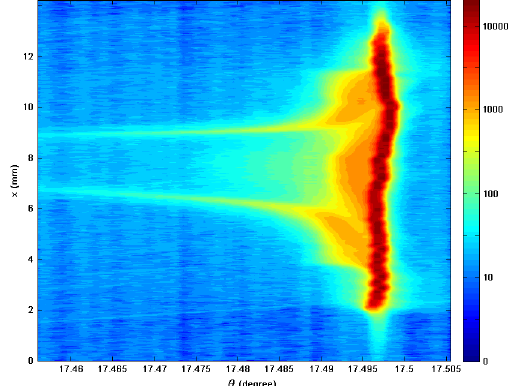
FIG. 11. Counts on the CCD detector as a function of the position along a diameter of the circular damage region ( x , vertical axis) and the diffraction angle.